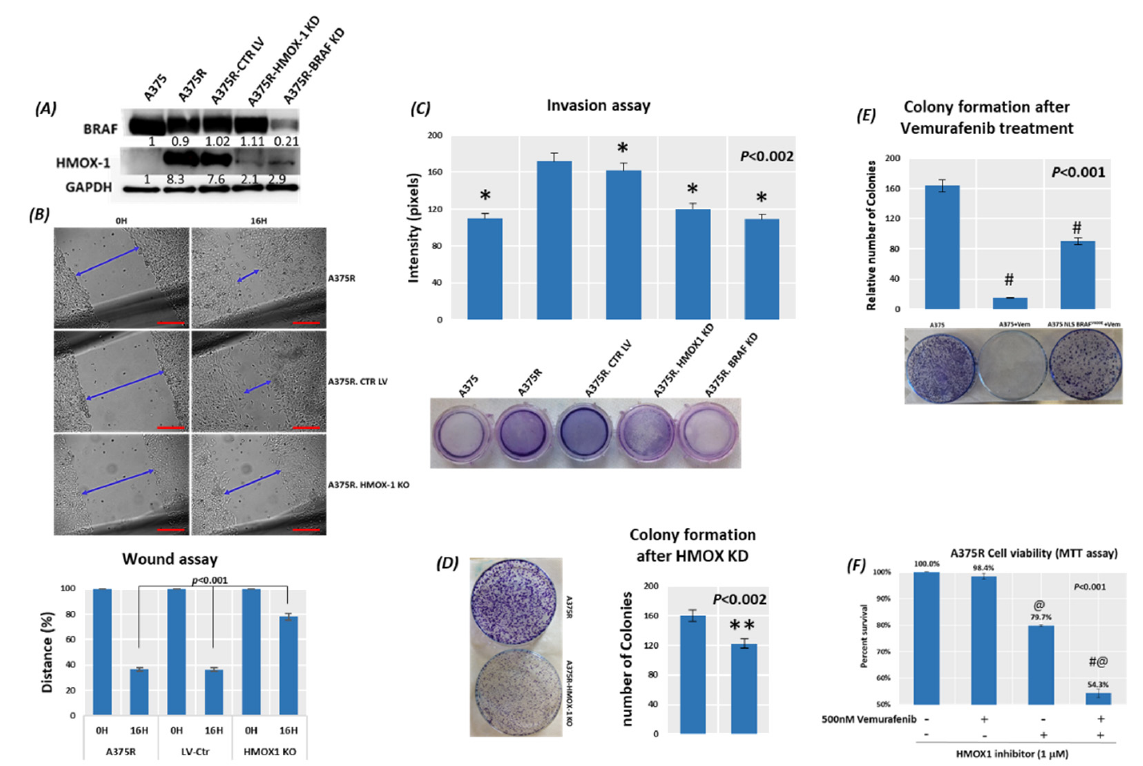
Figure 4. Suppression of HMOX-1 has an anti-proliferative effect in a resistant A375 (R) cell line. ( A ) The protein levels of BRAF V600E and HMOX-1 were measured in A375P and A375R cells with a knockdown of BRAF V600E or HMOX-1. Cell migration or invasion was evaluated by using a wound-healing assay ( B ) or invasion assay Scale bars = 200 µ m. 40 × magnification. All assays were performed in triplicate. * p < 0.002 compared with A375R ( C ) in A375R cells with knockdown of HMOX-1. ( D ) Representative colony formation of A375R cells with HMOX-1 knockdown. The assay was done in triplicate. ** p < 0.002 compared with A375R. ( E ) Colony formation of drug-sensitive A375 cells expressing NLS- BRAF V600E treated with 500 nM vemurafenib. # p < 0.001 compared with A375. ( F ) A375R cell viability was evaluated by MTT assay with the HMOX-1 inhibitor (OB-24) and/or in combination with vemurafenib. Means ± SEM are shown. @ p < 0.001 compared with control and # p < 0.001 compared with the treated HMOX1 inhibitor.